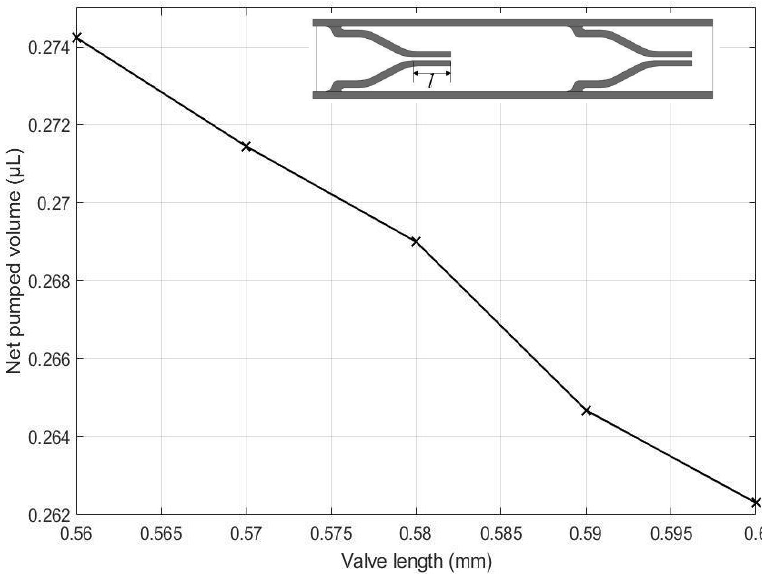
Figure 22. Effect of valve length on the net pumped volume.